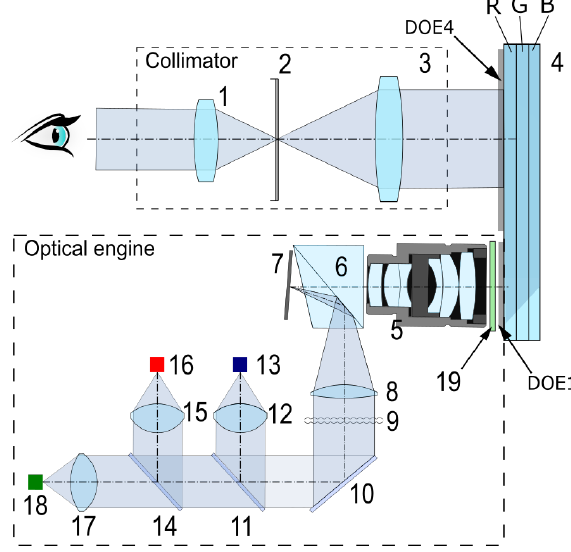
Figure 13. The scheme for determining the angular displacement of the output image. 1–3—collimator (2—measuring grid); 4—waveguide; 5–18—optical engine (13, 16, 18—LEDs; 8, 12, 15, 17—lenses; 10, 11, 14–mirrors; 9—microlenses; 6—prism; 7—display; 19—filter only for green LED).